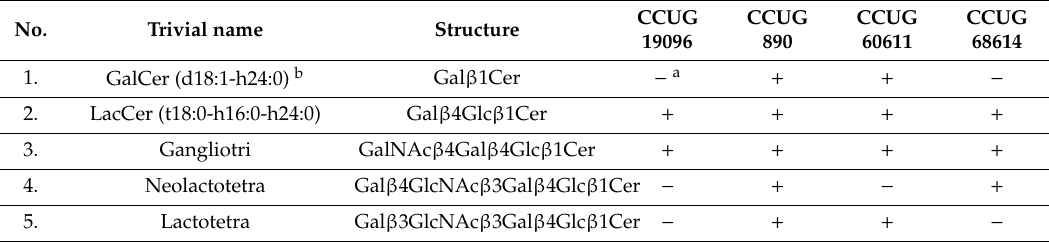
Table 2. Comparison of glycosphingolipid binding of Acinetobacter baumannii strains. No.